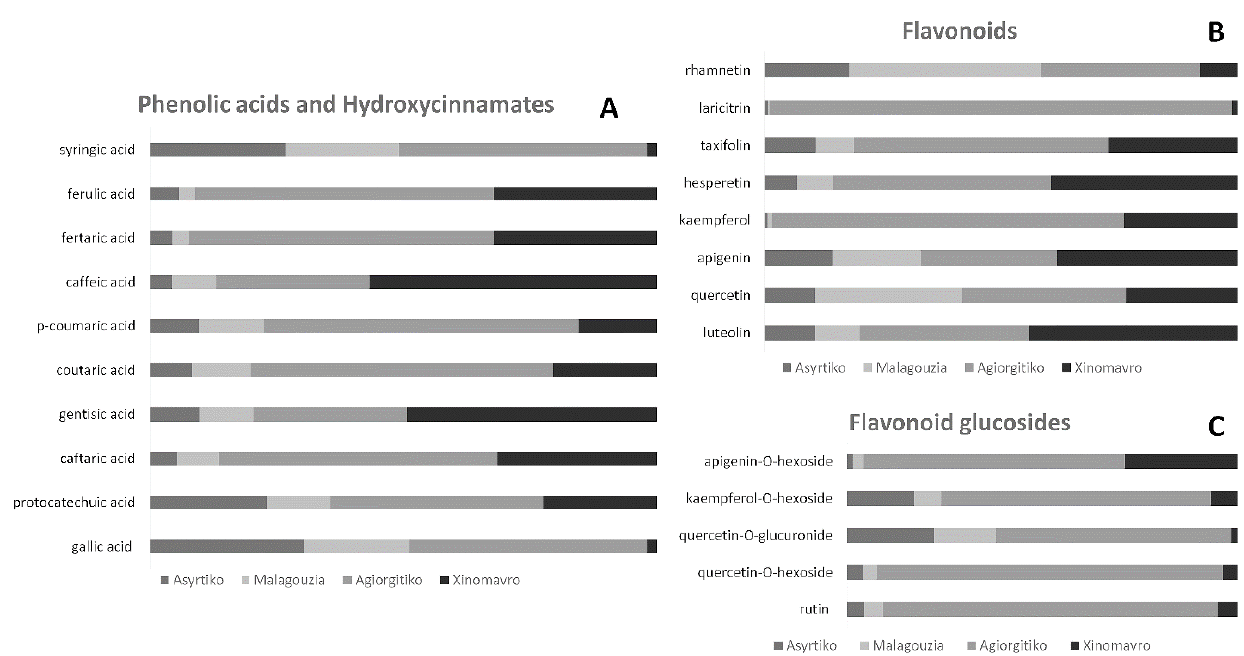
Figure 2. Comparative representation of ( A ) phenolic acids and hydroxycinnamates, ( B ) flavonoid, and ( C ) flavonoid glucoside in all wine extracts.